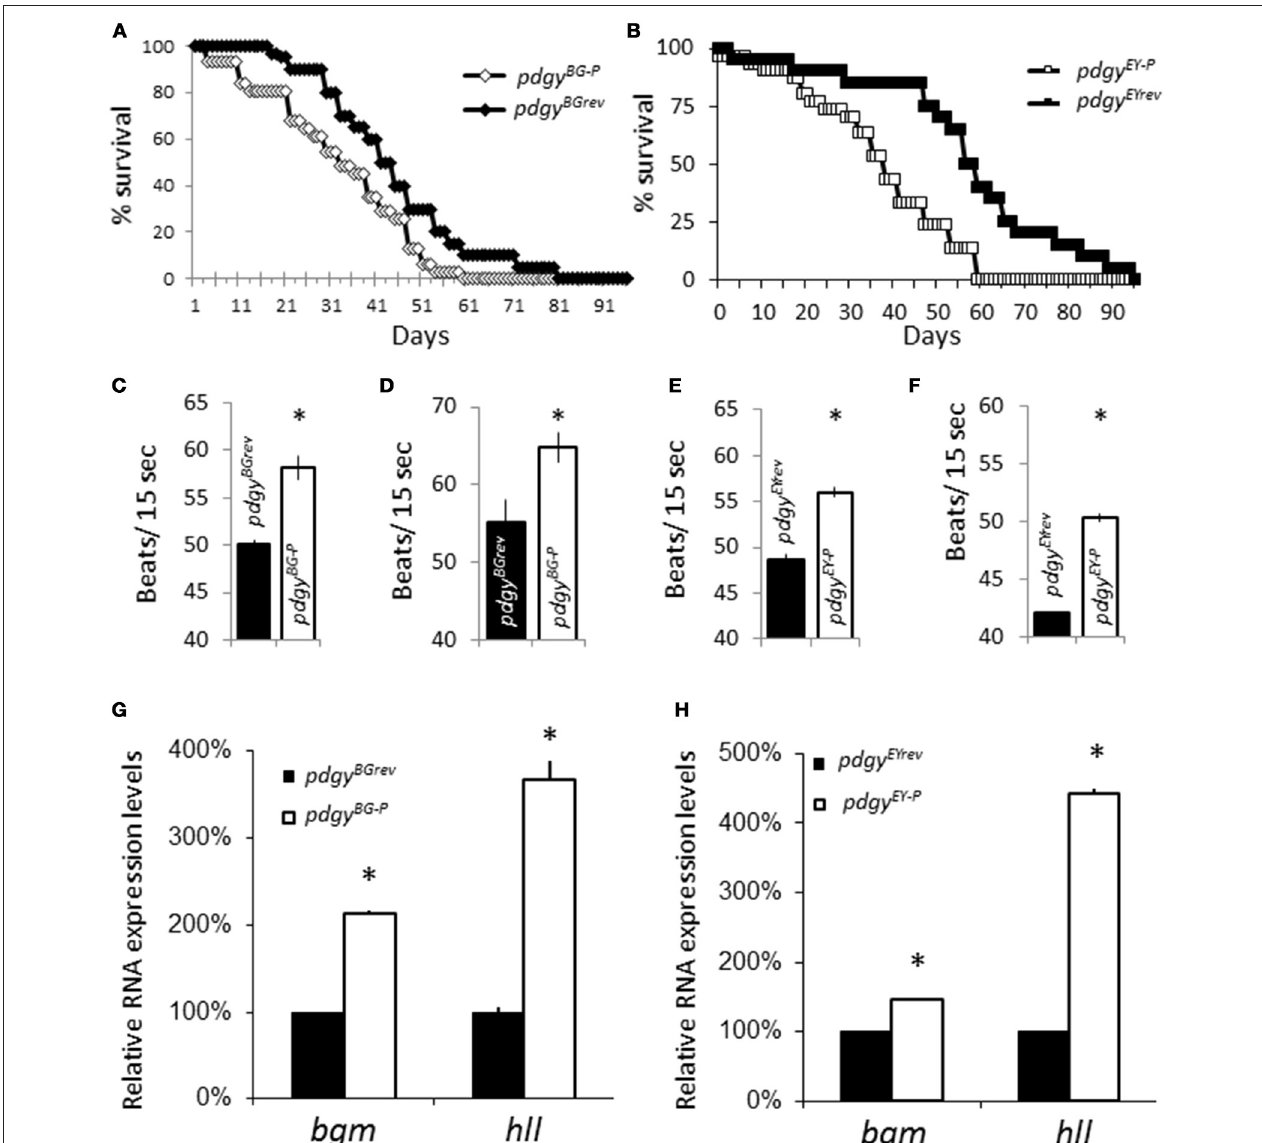
FIGURE 4 | Consequences of the pdgy mutants. (A) Lifespan measure for the pdgy BG − P ( n = 30) compared to the revertant control, pdgy BGrev ( n = 30). (B) Lifespan measure for the pdgy EY − P ( n = 30) compared to the revertant control, pdgy EYrev ( n = 30). pdgy BG − P has increased heart rates compared to background controls at (C) 9–11 d.o. and (D) 22–25 d.o. A similar phenotype is observed in pdgy EY − P compared to background controls at (E) 9–11 d.o. and (F) 22–25 d.o. (G) Levels of the ACSs bubblegum ( bgm ) and heimdall ( hll ) are elevated in the pdgy hypomorph ( pdgy BG − P in G ) and ( pdgy EY − P in H ) compared to the revertant control. * p <